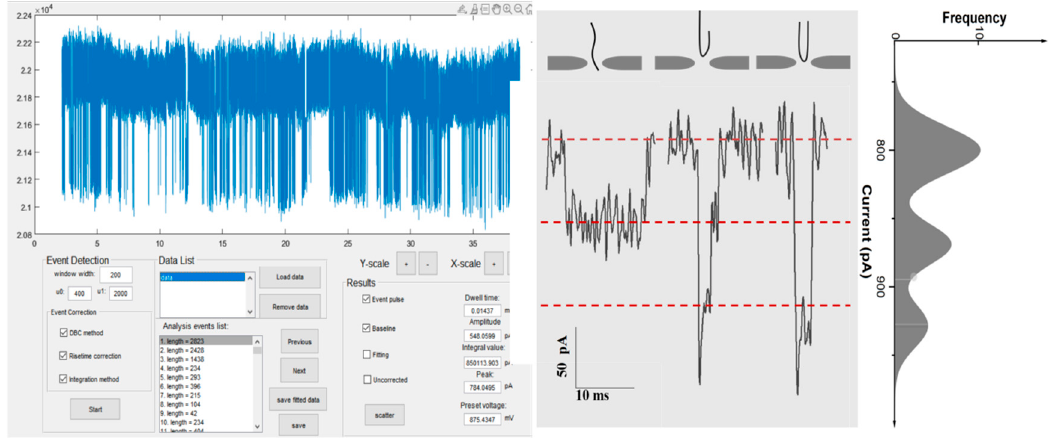
Figure 4. DNA detection by the nanopore sensor based on the MATLAB program.